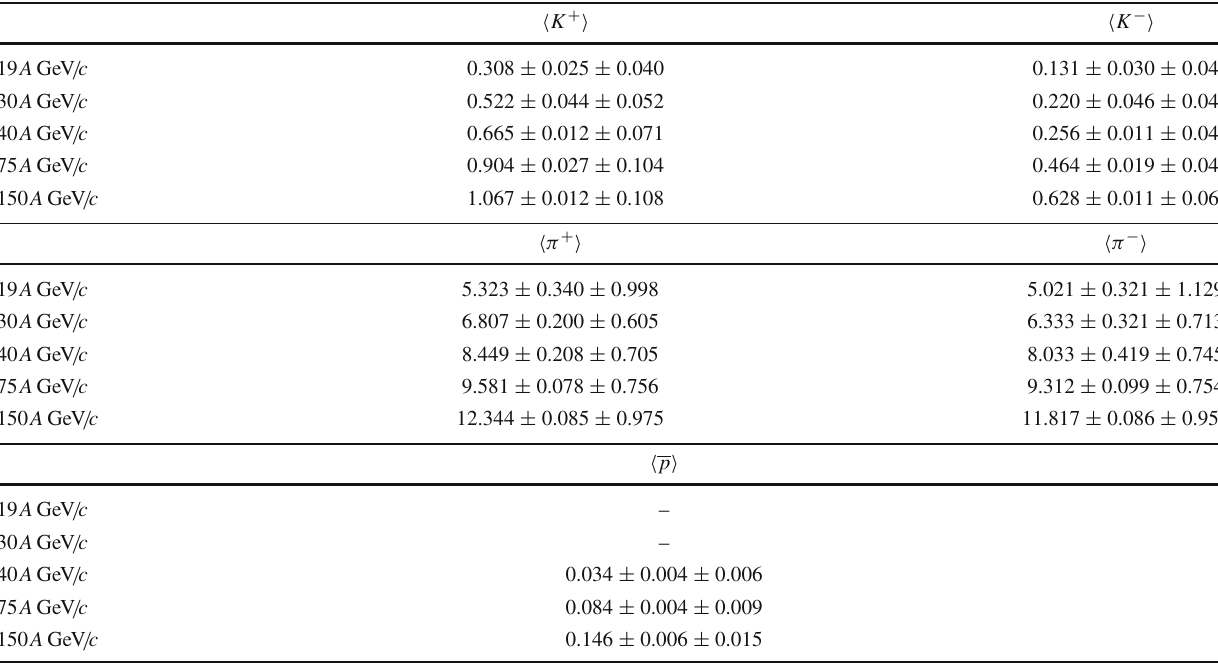
Table 5 Mean multiplicities of K + , K − , π + , π − , protons and antiprotons produced in the 20% most central Be+Be collisions. For each value the statistical and systematic uncertainties are given as a first and second uncertainty contribution respectively